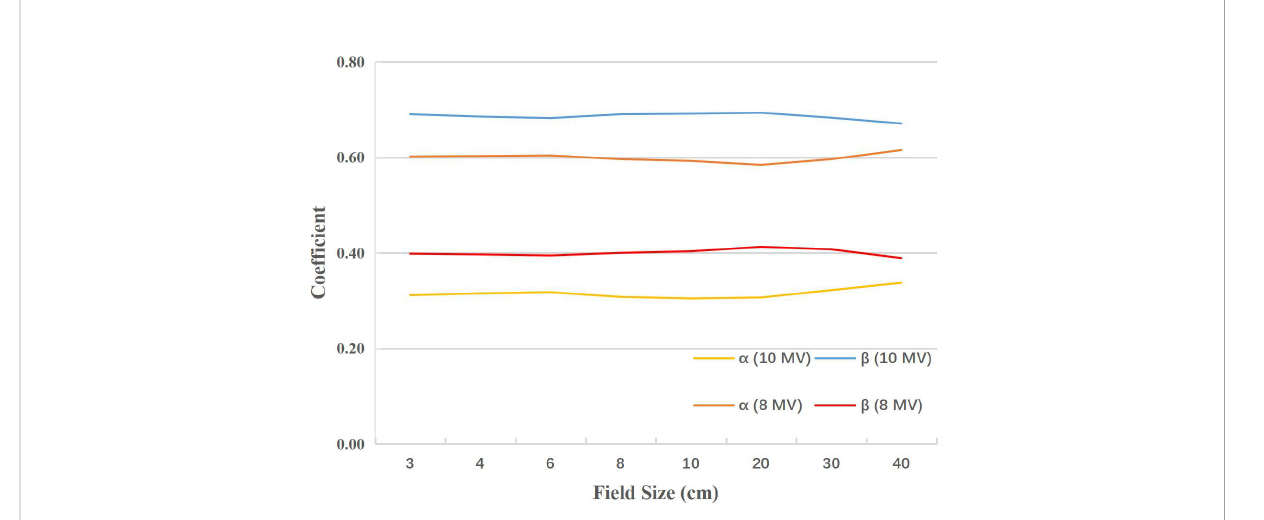
FIGURE 1 The synthesis coef fi cients ( a , b ) as a function of fi eld size for E syn -8MV and E syn